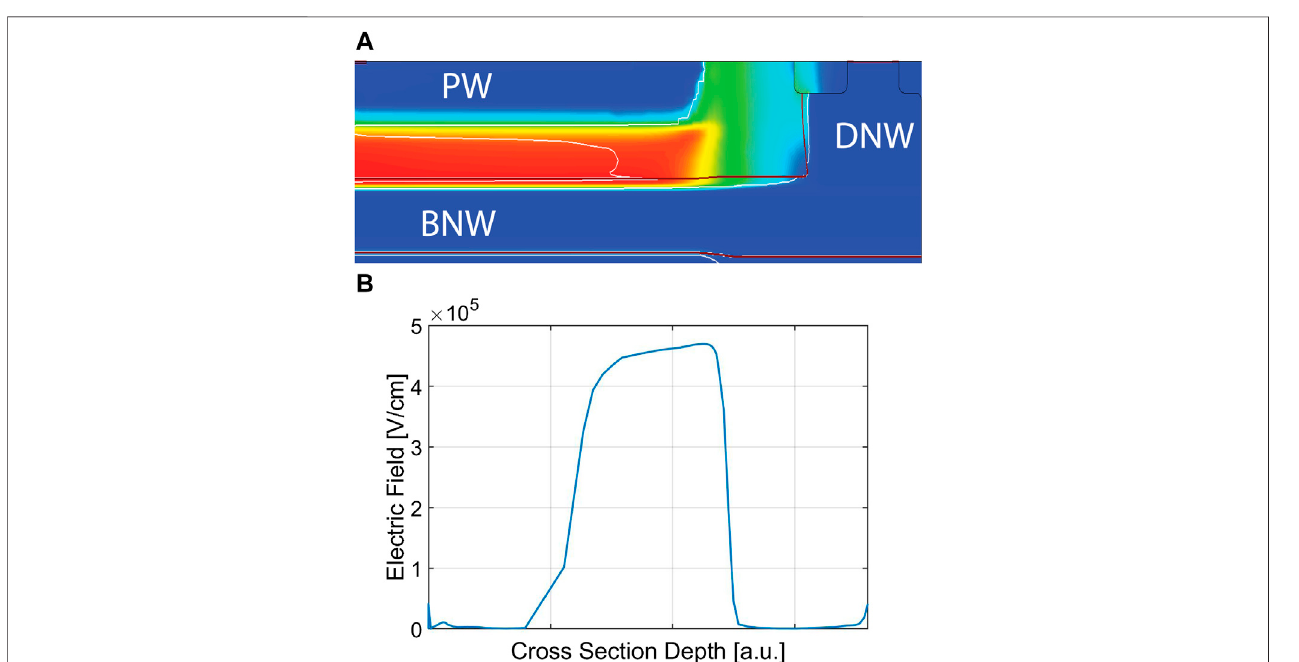
FIGURE 2 | TCAD simulation of the 2D electric fi eld distribution in the cross section (A) . A quanti fi cation of the electric fi eld along the vertical axis is also shown (B) [21].